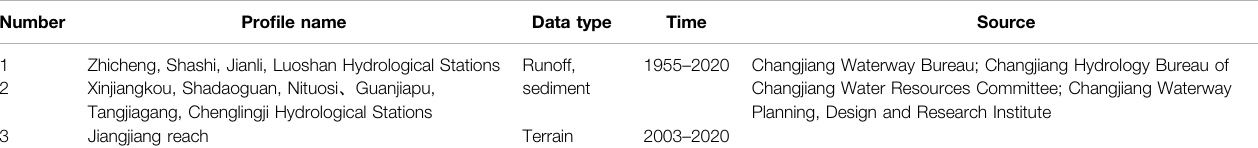
TABLE 1 | Data characteristics and sources.